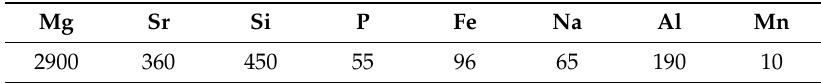
Table 1. Impurity concentrations, in µ g/g (ppm), in the Ca(OH) 2 used in this study measured by